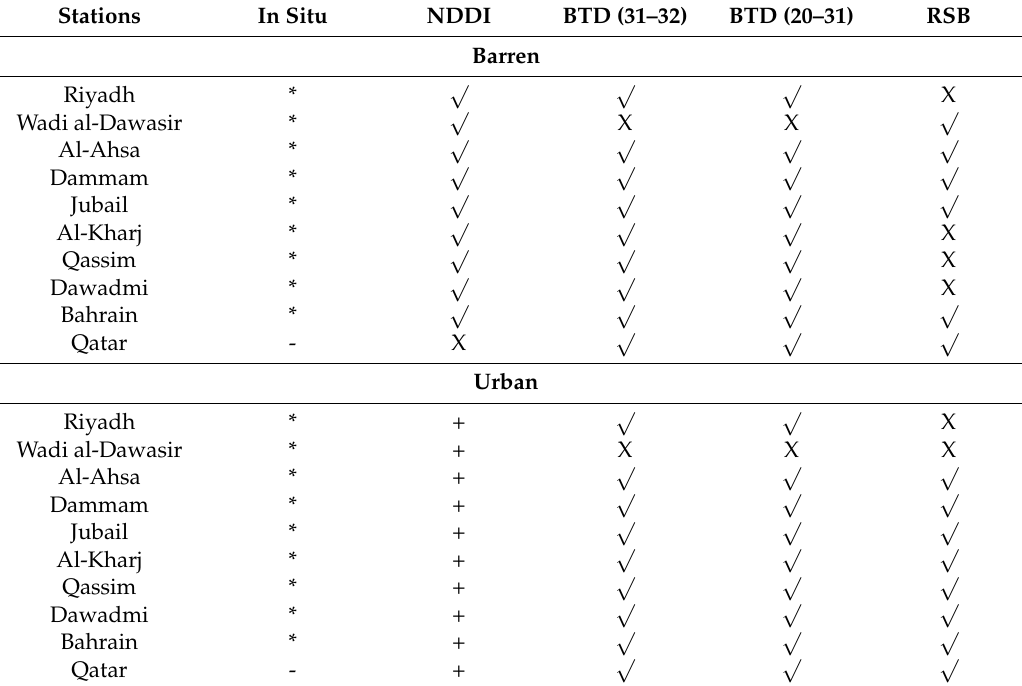
Table 1. The Validation of Index Performance over Different Land Cover (Dust Event: 2 February 2012).